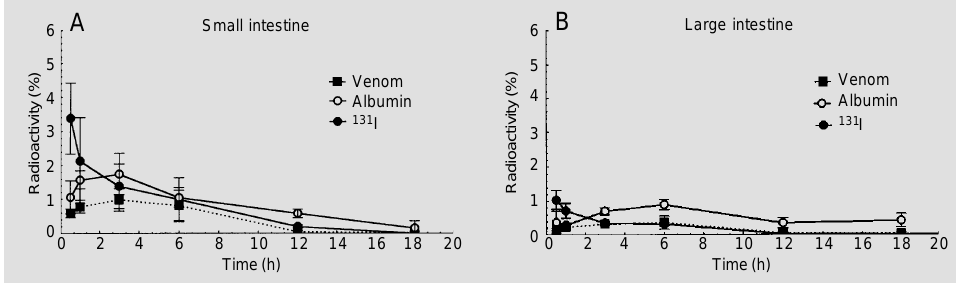
Figure 2 - Distribution of Bo- throps erythromelas venom, al- bumin and iodine in the small intestine (A) and large intestine (B) of animals submitted to per- fusion. Radioactivity is reported as percentage of the total in- jected dose. Data are reported as the means ± SD for 3 experi-